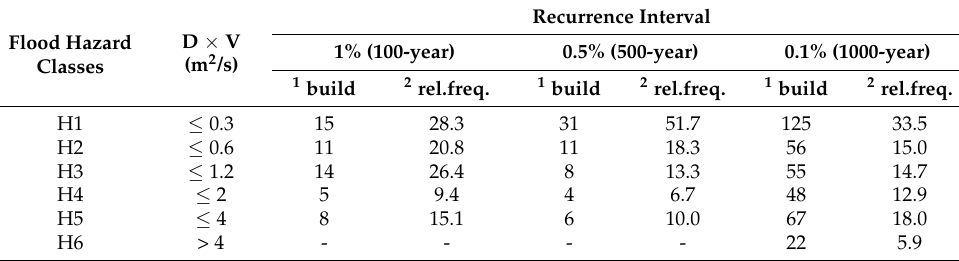
Table 9. Number of potentially affected buildings by flood vs. D × V hazard classes computed for each dam break scenario with 1% (100-year), 0.5% (500-year), and 0.1% (1000-year) recurrence intervals. Flood Hazard